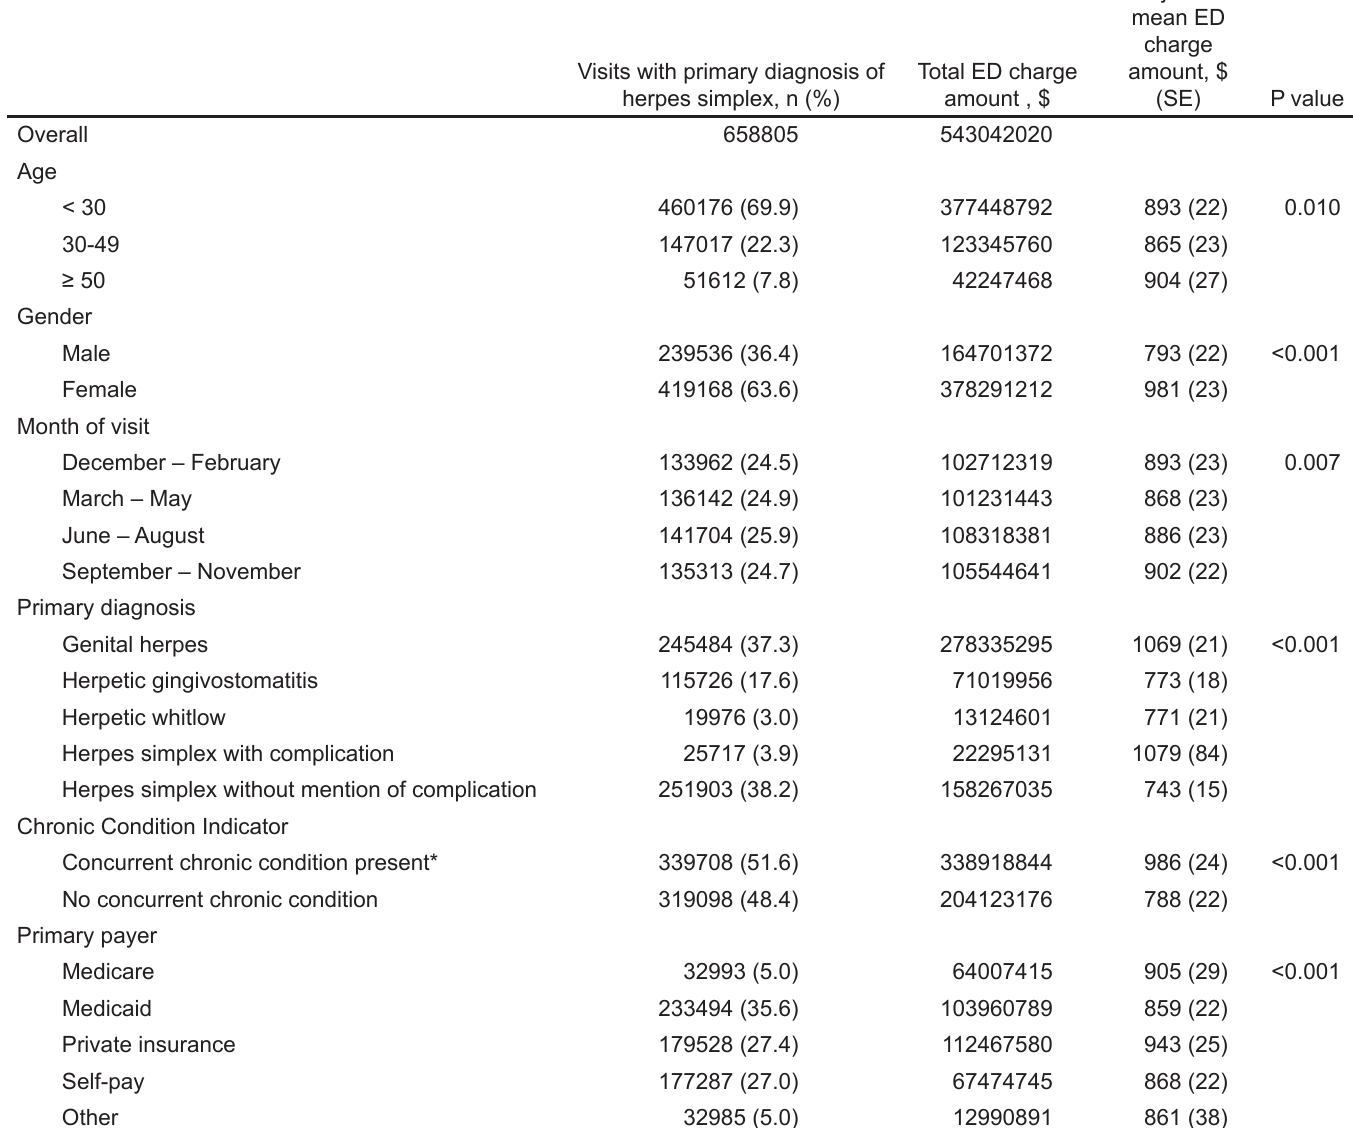
Table 1. Nationwide herpes simplex virus infection emergency department routine disposition visits and costs